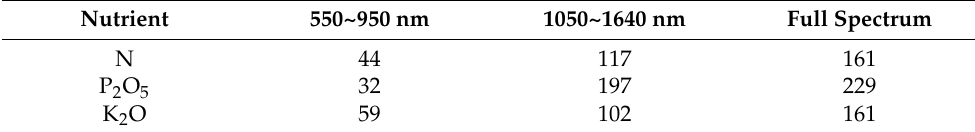
Table 2. The result of characteristic wavelength